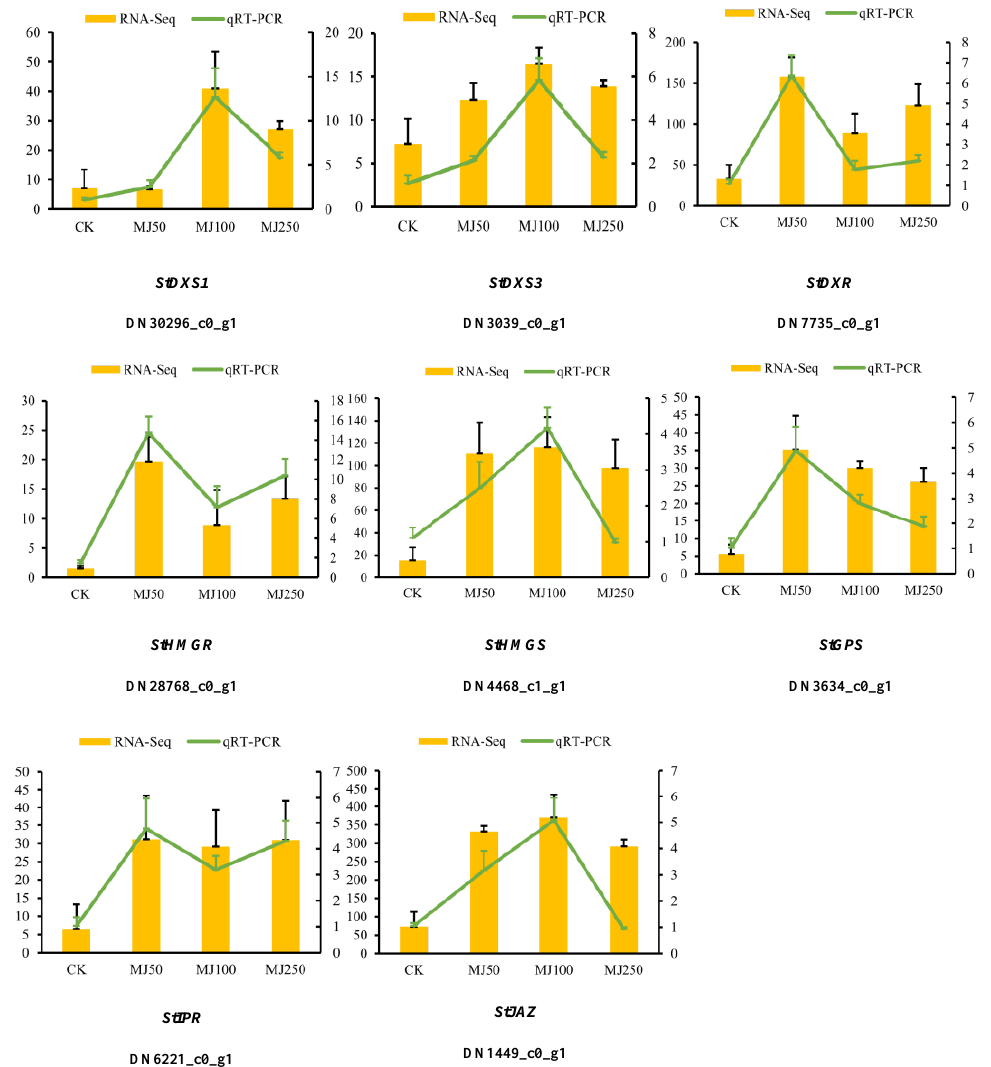
Figure 9. The qRT-PCR validation of eight differentially expressed genes. Bar graphs indicate RNA- Seq expression, solid lines indicate qRT-PCR relative expression. The left Y-axis is the FPKM value of RNA-Seq, and the right Y-axis is the qPCR relative expression value.